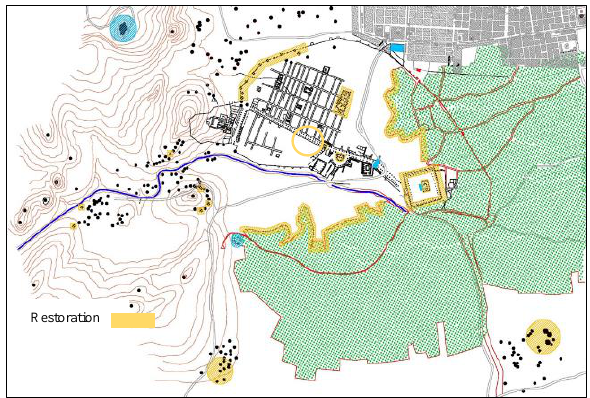
Figure (36) the outline of the areas where the need for